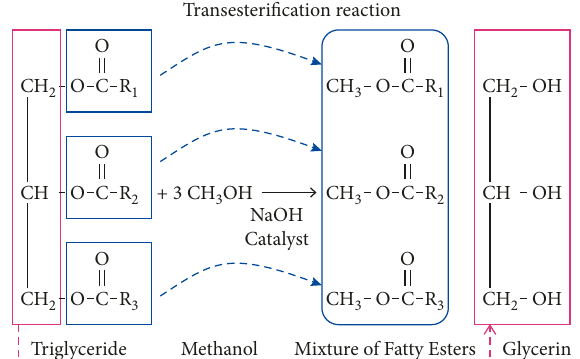
Figure 1: Transesterification reaction of Chlorella sp. micro algae